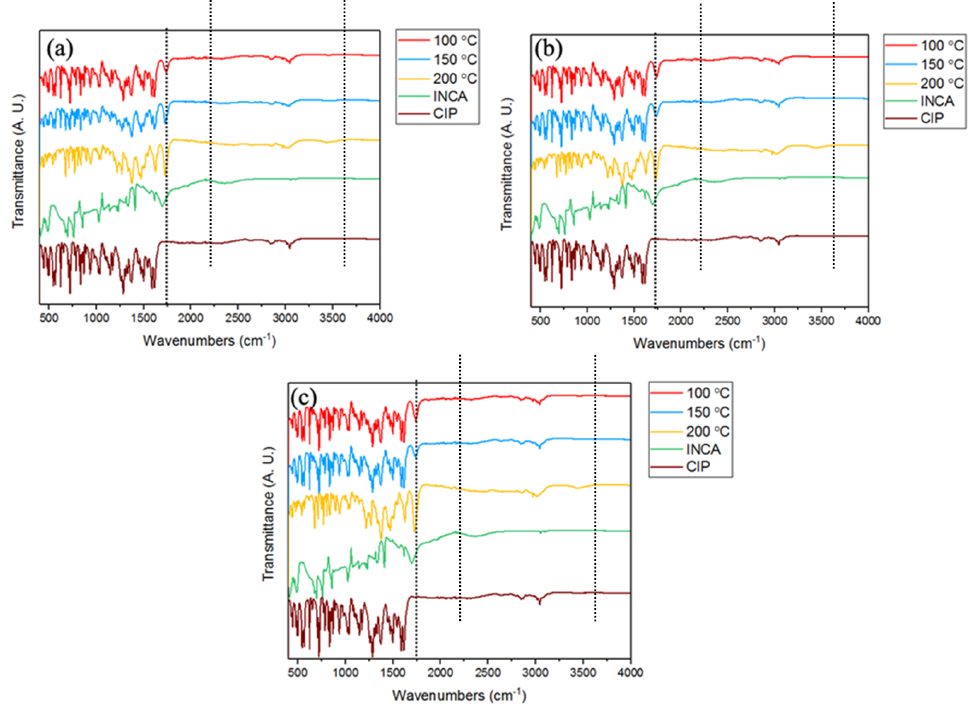
Figure 11. FTIR spectra of samples extruded at various temperatures and screw speeds using conveying screws ( a ) 10 rpm, ( b ) 55 rpm, and ( c ) 100 rpm.